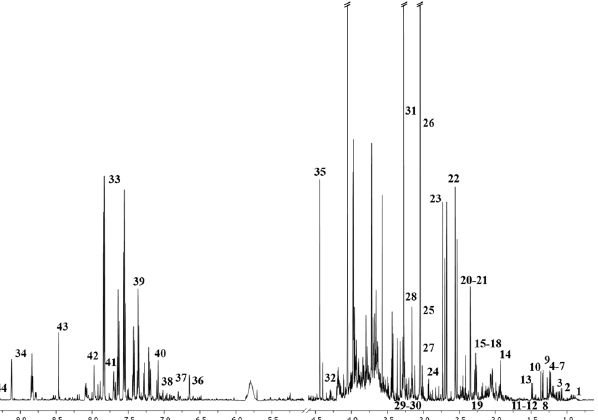
Figure 2. The representative spectrum 1 H NMR obtained from the urine samples of HC subjects. The following metabolites are identified: 1, Unk_1; 2, 3-Hydroxyisobutyrate; 3, 3-Methyl-2-oxovalerate; 4, Isopropanol; 5, 3-Hydroxybutyrate; 6, Methylmalonate; 7, Fucose; 8, 3-Hydroxyisovalerate; 9, Lactate; 10, 2-Hydroxyisobutyrate; 11, 2-Phenylpropionate; 12, Unk_2; 13, Alanine; 14, Acetate; 15, Unk_3; 16, Unk_4; 17, N-Isovaleroylglycine; 18, Acetone; 19, 2-Aminoadipate; 20, Unk_5; 21, Unk_6; 22, Citrate; 23, Dimethylamine; 24, Unk_7; 25, Creatine; 26, Creatinine; 27, Carnitine; 28, TMAO; 29, Unk_8; 30, Unk_9; 31, Glycine; 32, Glycylproline; 33, Hippurate; 34, Trigonelline; 35, Ascorbate; 36, 2-Furoylglycine; 37, 3-Hydroxyphenylacetate; 38, Tyrosine; 39, N-Phenylacetylglycine; 40, 3-Indoxylsulfate; 41, Unk_10; 42, Formate; 43, Unk_11; 44,